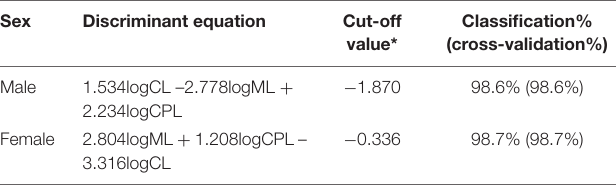
TABLE 2 | Discriminant equations of maturity status in P. polyphagus